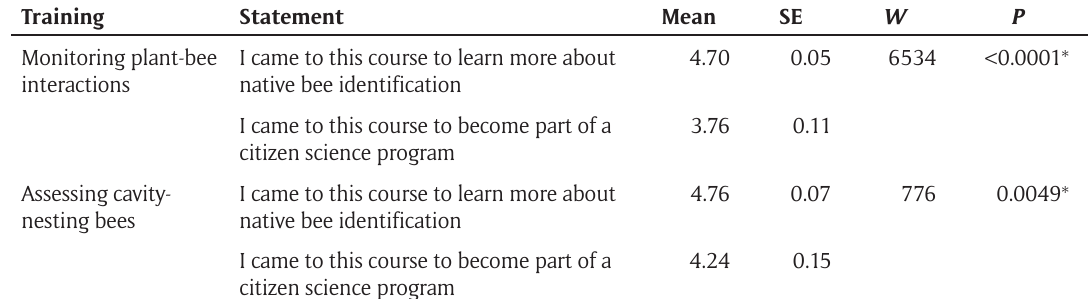
Table 3: Results of Wilcoxon rank sum tests comparing whether volunteers in each training were primarily motivated by educational goals or to become part of a citizen science project. P values below α = 0.05 (shown with an asterisk) indicate a significant difference between the two possible motivations for each particular